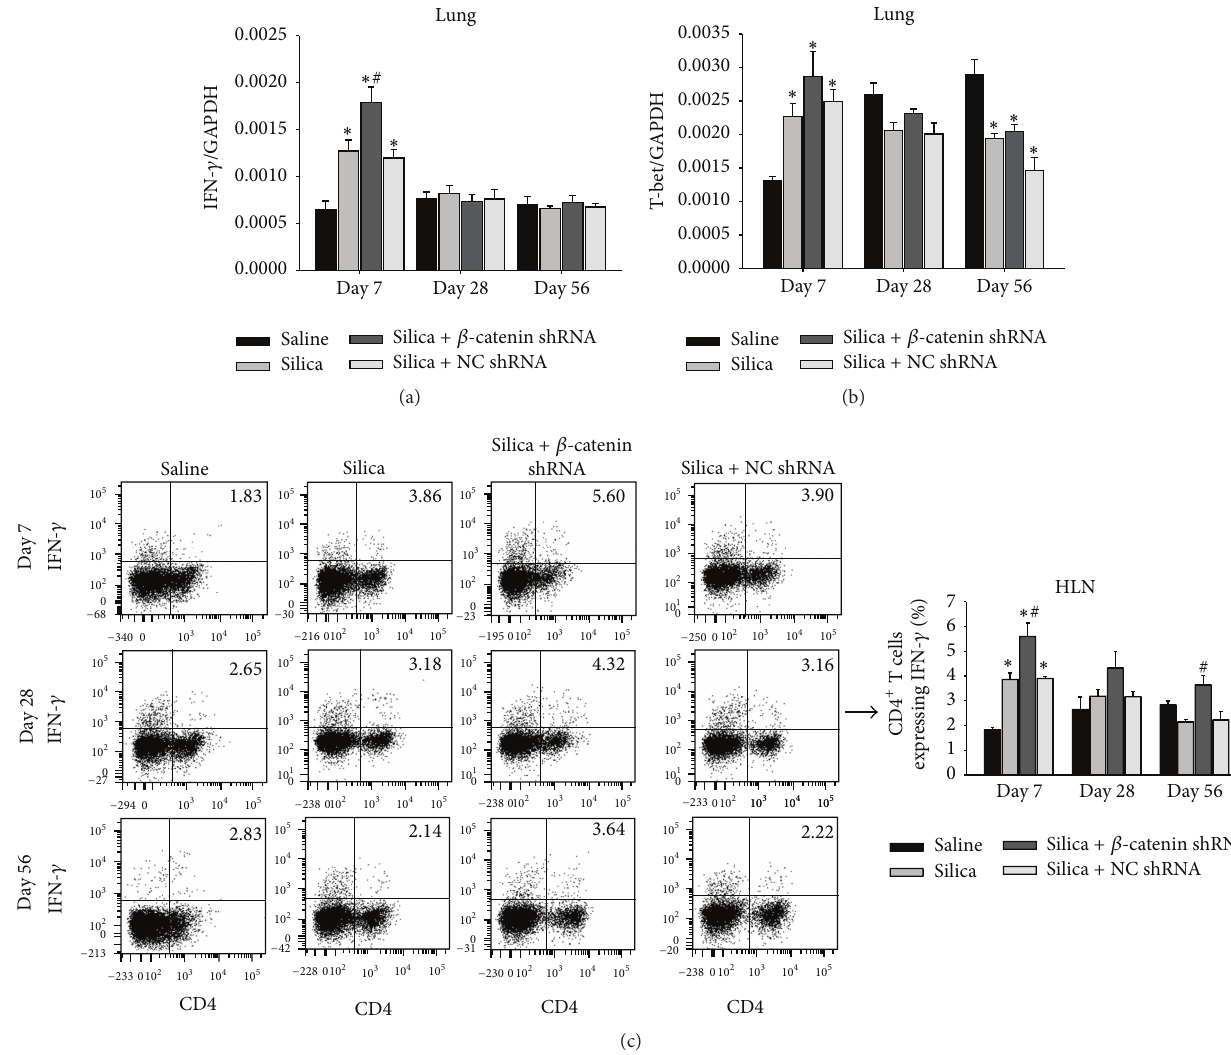
Figure 5: Th1 response was enhanced by blocking the Wnt/ 𝛽 -catenin pathway. Expressions of IFN- 𝛾 (a) and T-bet (b) in lung were assayed by real-time RT-PCR using the −ΔΔ Ct method. (c) The percentage of IFN- 𝛾 + CD4 + T cells in HLN was calculated by flow cytometry; data were shown as scatter plot and graph. Values are shown as mean ± SEM ( 𝑛 = 4 -5) ( ∗ , as compared with saline group at the same time point, 𝑝 < 0.05 ; #, as compared with silica group and silica + NC shRNA group at the same time point, 𝑝 < 0.05